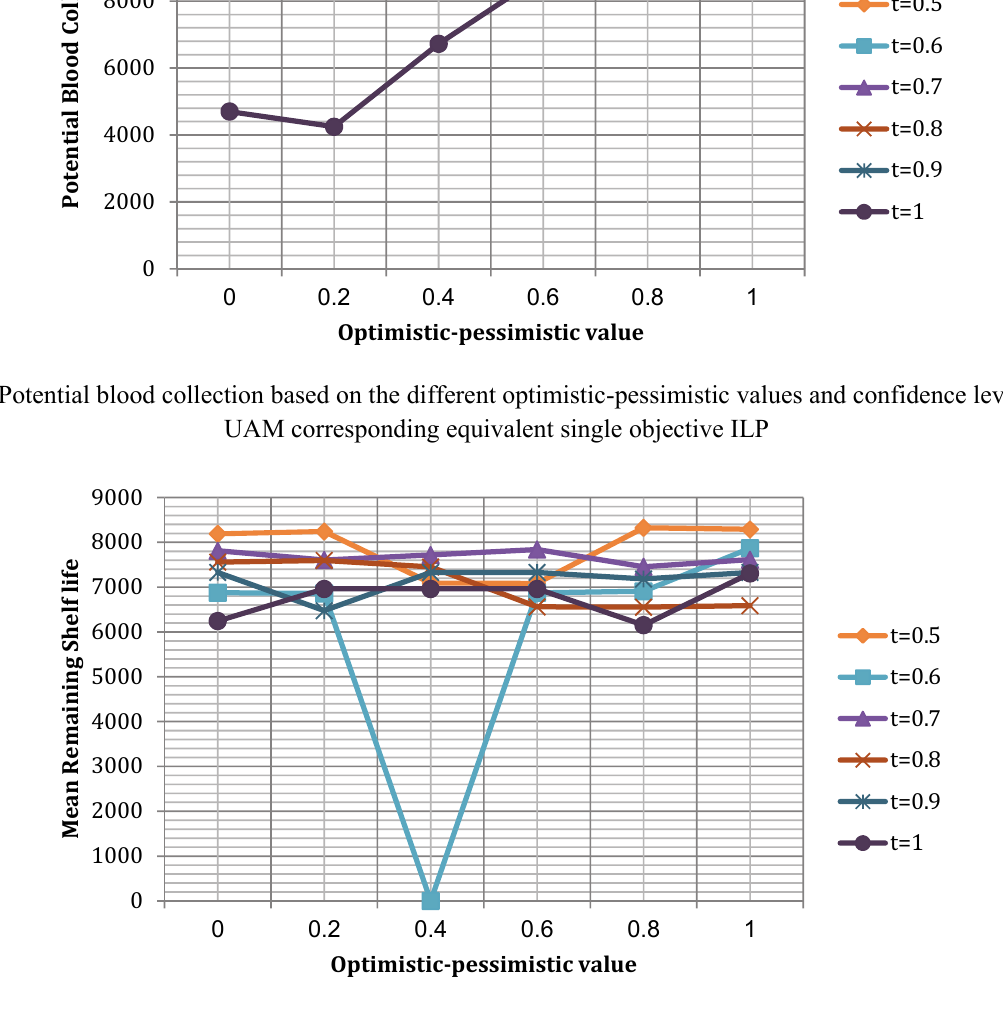
Fig. 4. Potential blood collection based on the different optimistic-pessimistic values and confidence levels for LAM corresponding equivalent single objective